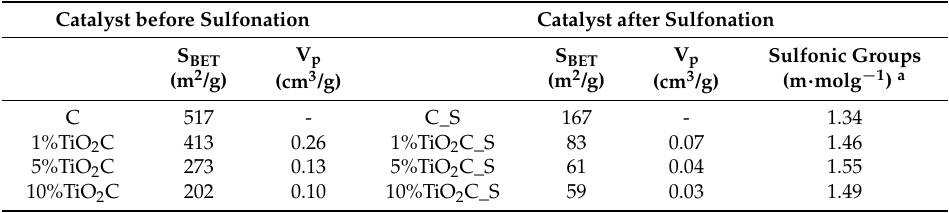
Table 1. Textural properties and hot filtration results of carbon spheres and TiO 2 C nanocomposites. Catalyst before